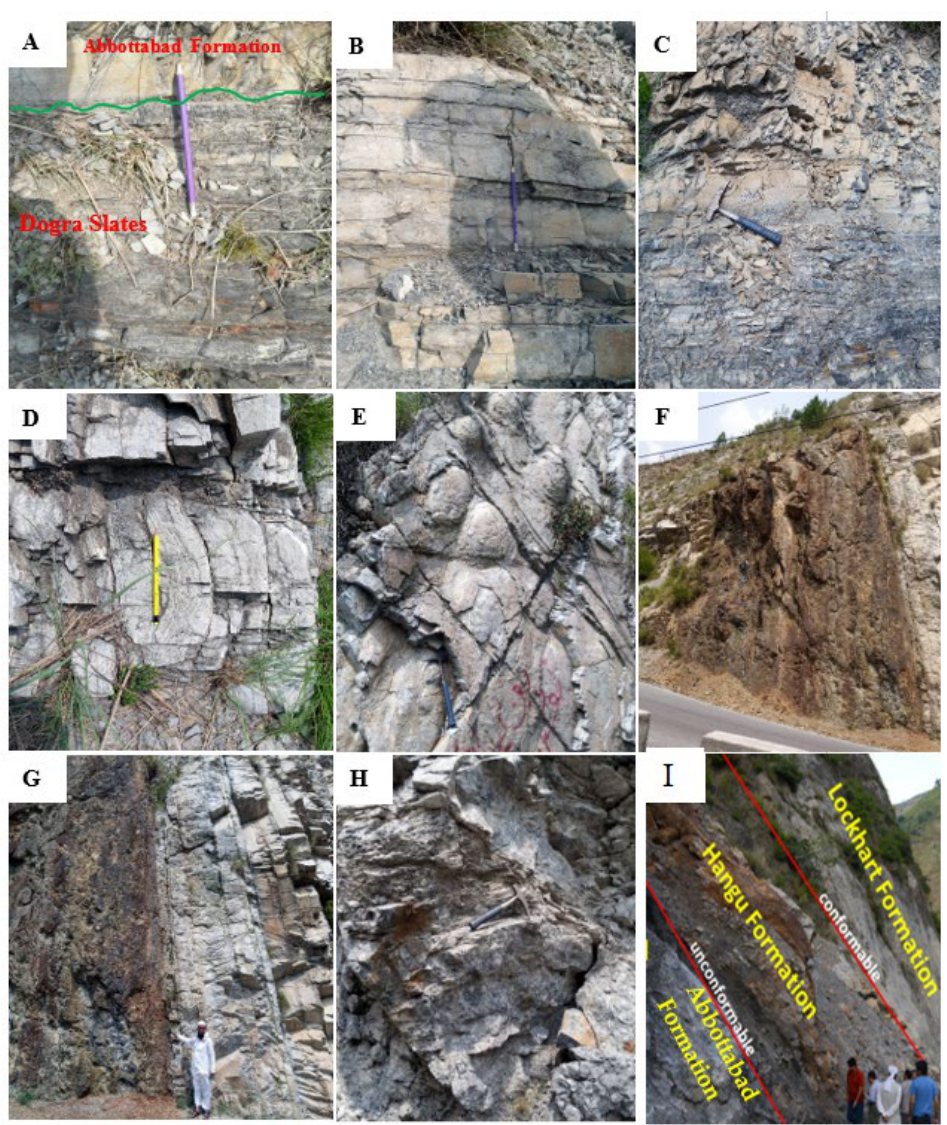
Figure 5. Detailed field characteristics and lithofacies of the Abbottabad Formation at Kamsar-Yadgar section, Muzaffarabad: ( A ) non-conformable contact between the Dogra slate and thin interbedded dolomite of the Abbottabad Formation (LA-1); ( B ) thinly bedded dolomite with blackish shale (LA-1); ( C ) thinly bedded greyish dolomite (LA-1); ( D ) thinly laminated convex algal mats (LA-2); ( E ) thick dome-shaped stromatolites (LA-2); ( F ) reddish brown, rusty stained, brecciated, and highly limonitic dolomitic zone (LA-3); ( G ) contact between the limonitic, brecciated zone, and medium bedded algal mat dolomite; ( H ) snow white, brecciated quartzite (LA-4); ( I ) composite unconformity between the brecciated quartzite of the Abbottabad Formation and the Hangu